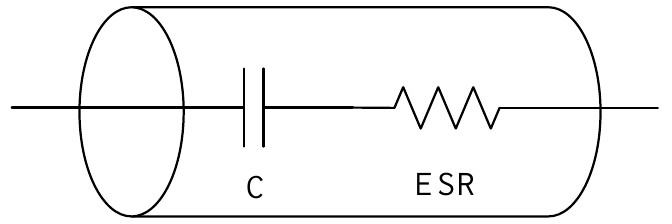
Figure 3. Electrical model of an electrolytic capacitor.